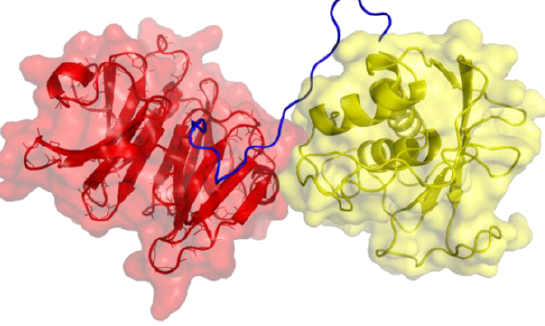
Figure 1. Three-dimensional structure of MMP-1. The catalytic (CAT) domain is yellow, the linker/hinge is blue, and the hemopexin-like (HPX) domain is red. The structure is based on X-ray crystallographic analyses of full-length MMP-1 [5,6].